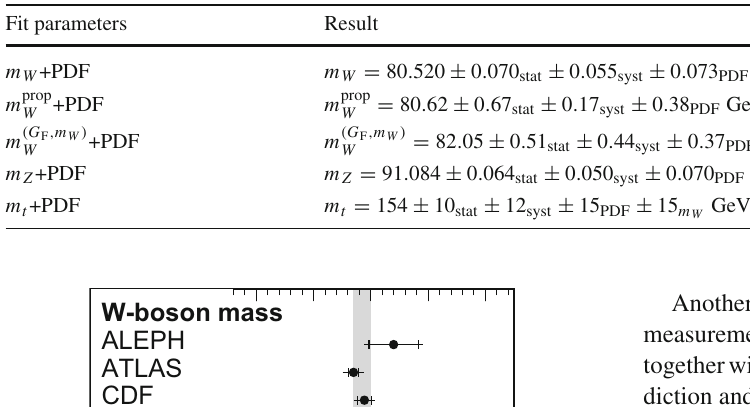
Table2 Resultsforfivecombinedfitsofmassparameterstogetherwith PDFs. The multiple uncertainties correspond to statistical (stat), exper- imental systematic (syst) and PDF uncertainties. The m t determination